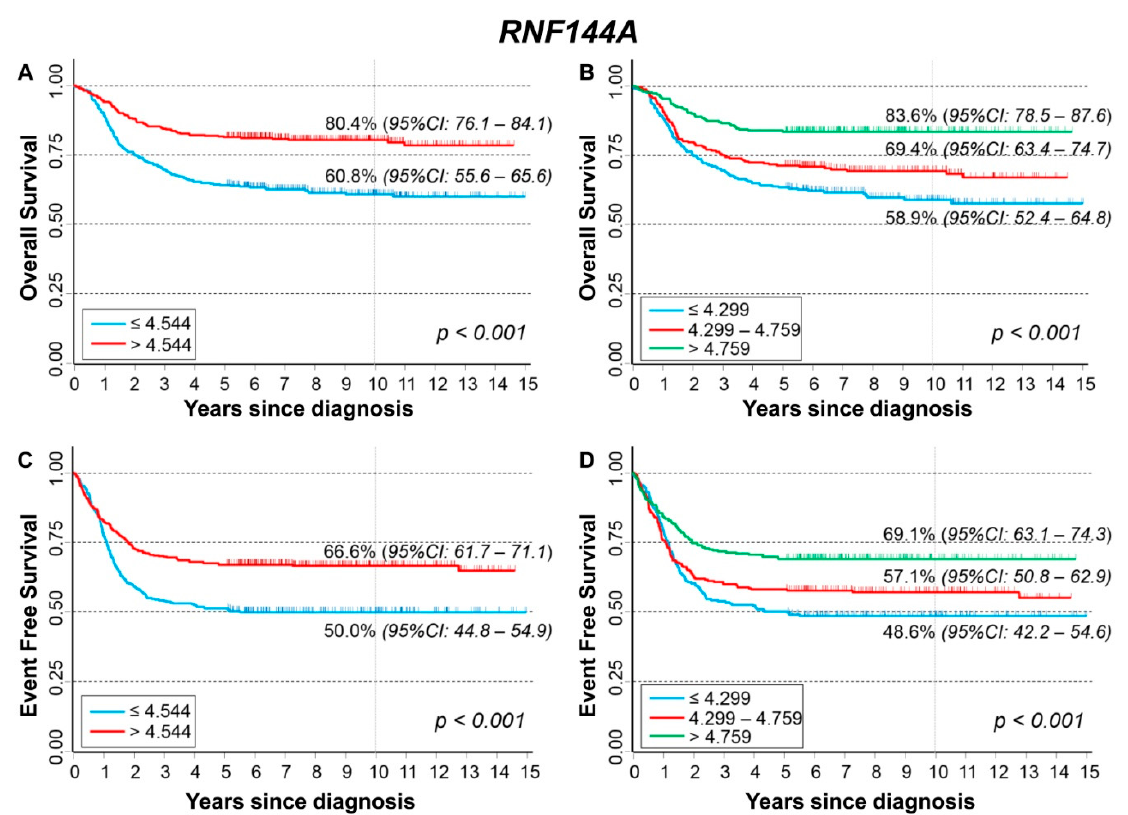
Figure 3. Patient Survival in relation to RNF144A expression level. Overall Survival of 786 NB patients with ( A ) cut-off based on the median expression value or ( B ) on tertile expression values. Event Free Survival of 769 NB patients with ( C ) cut-off based on the median expression value or ( D ) on tertile expression values. Ten-year survival estimates are displayed. Table 2. Overall Survival of 786 NB patients in relation to RNF144A expression levels evaluated by the Cox model.